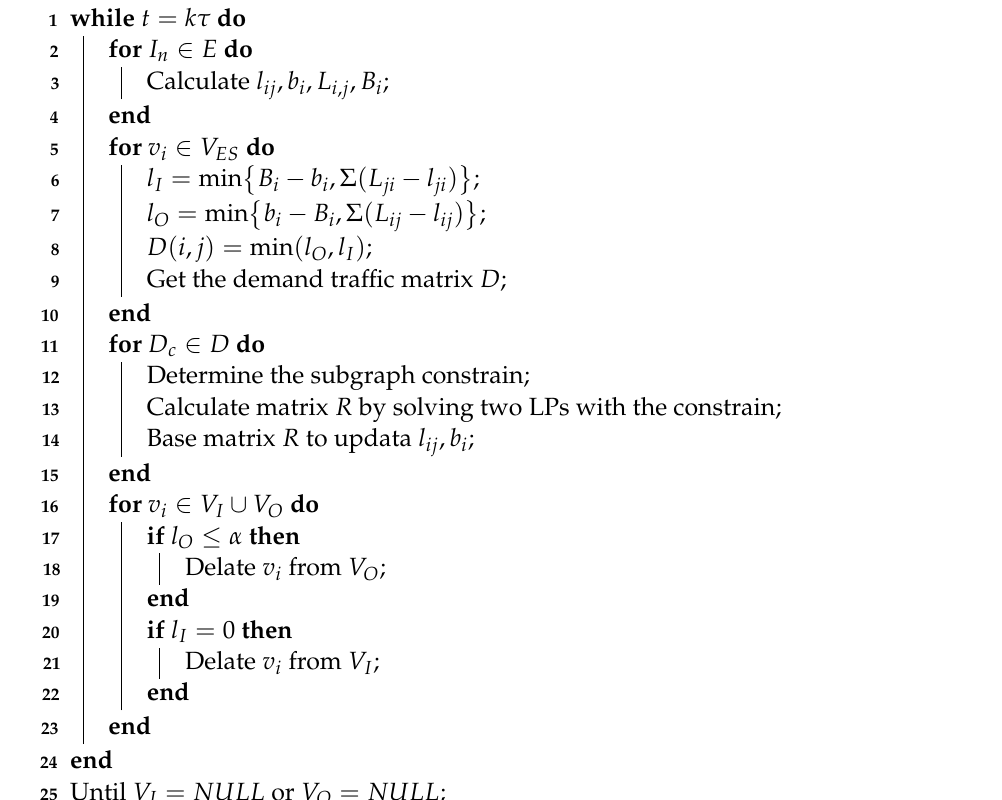
Algorithm 1: Downloading Algorithm